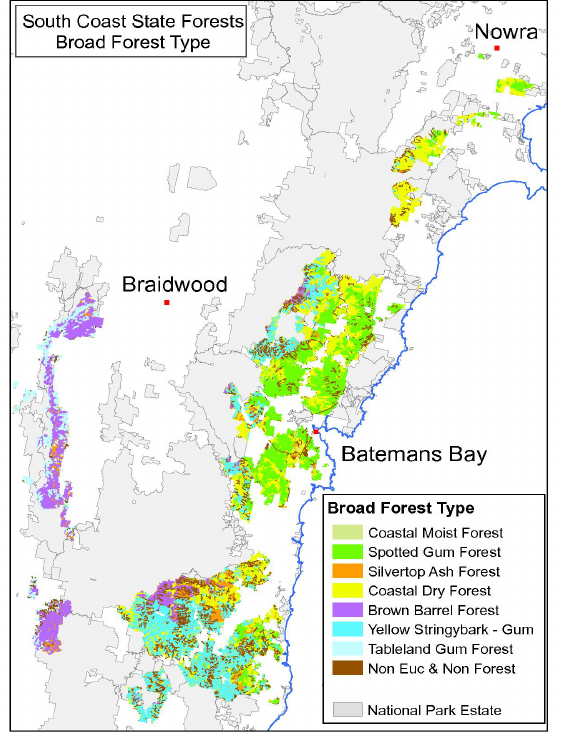
Figure 2. South Coast case study